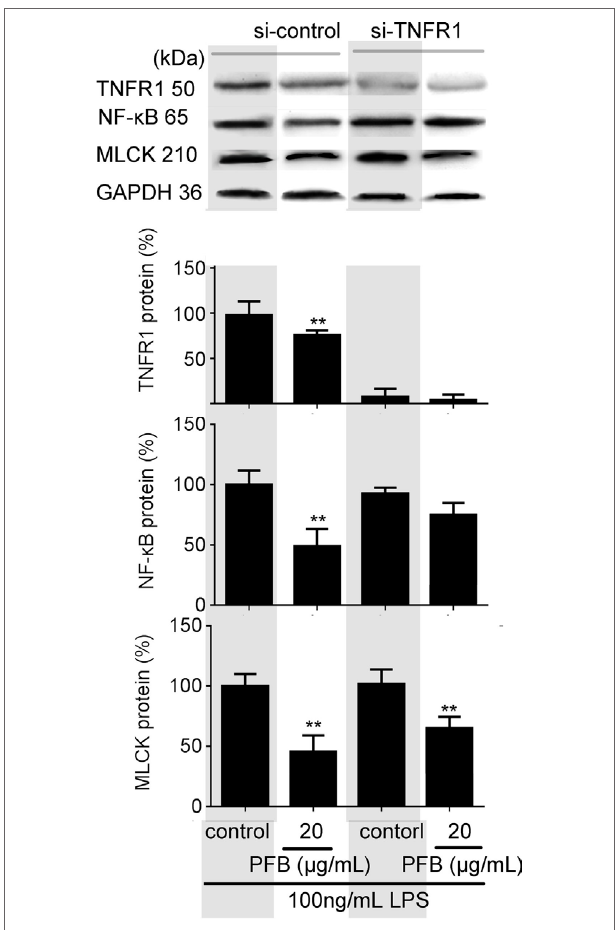
FigUre 7 | Downregulation of TNFR1 in purified fruit bromelain (PFB)-induced inhibition of inflammation and epithelial barrier dysfunction. Effects of PFB on expression of NF- κ B and myosin light chain kinase (MLCK) in the presence of small interfering RNA targeting TNFR1. Data are expressed as the mean ± SD. Values are given relative to LPS-treated group (control, 100%) and other values are given relative to the control: ** P < 0.01 compared with LPS